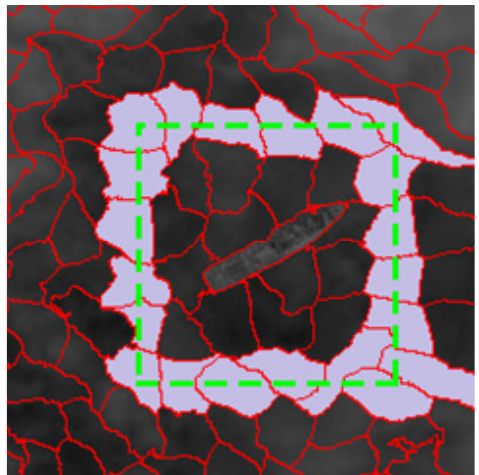
Figure 2. Reference window setup. The tested superpixel is the superpixel in the center of the green dashed box, and the surrounding clutter superpixels (shown in lavender) are selected for clutter parameter estimation. The selected lavender superpixel is the nearest non-adjacent superpixel of the tested superpixel.